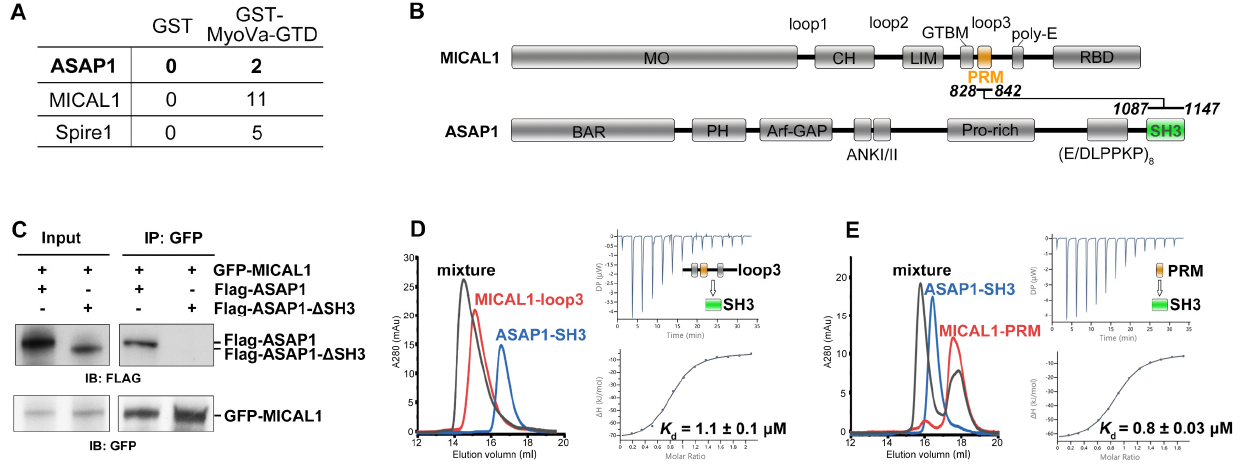
Figure 1. Identification of the MICAL1 and ASAP1 interaction mediated by the SH3/PRM recognition. ( A ) Peptide counts of ASAP1, MICAL1 and Spire1 binding to GST or GST-MyoVa-GTD by mass spectrum detection. ( B ) Domain organization of MICAL1 and ASAP1. The potential interacting regions of MICAL1-PRM and ASAP1-SH3 are highlighted. ( C ) The co-IP result showing the association of MICAL1 to ASAP1, but not ASAP1- Δ SH3, which is derived from Figure S1B. ( D , E ) aSEC and ITC investigations on the binding of ASAP1-SH3 to MICAL1-loop3 ( D ) and MICAL1-PRM ( E ), respectively.